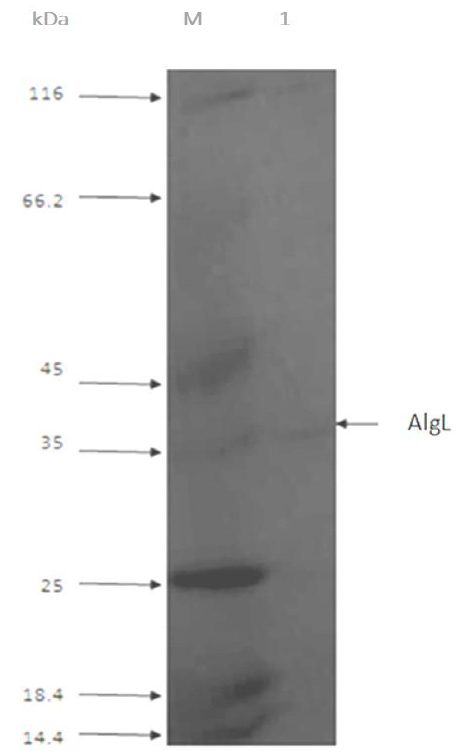
Fig. 4. The SDS-PAGE electrophoresis of AlgL from P.aeruginosa strain 214. Protein size marker (M), purified AlgL with DEAE-Sepharose Cl-6B column chromatography (1) were electrophoretically separated on a 15% running, 4%